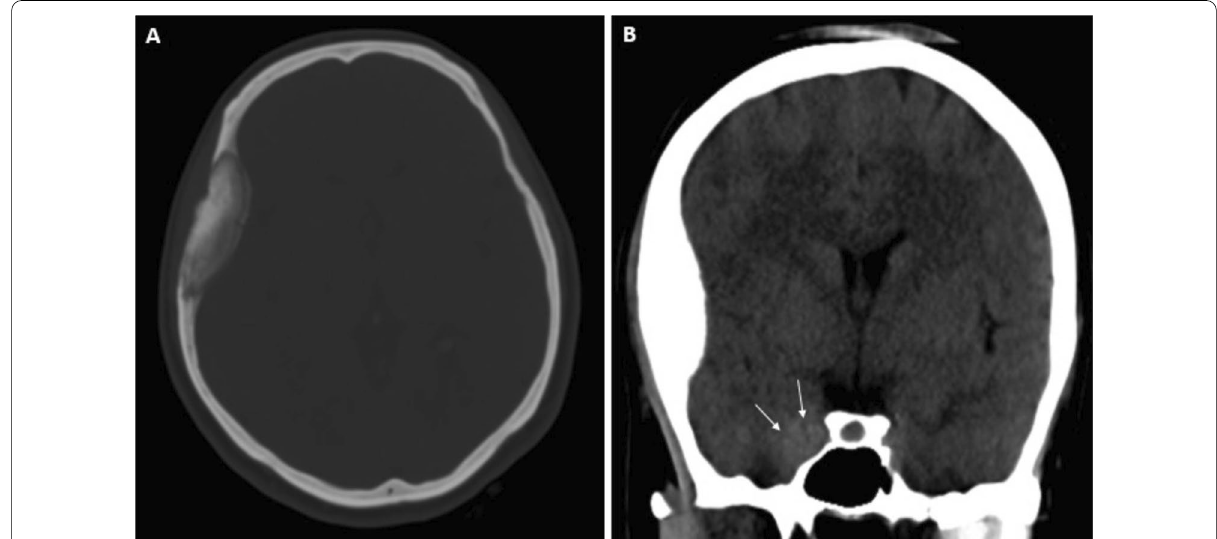
Fig. 1 In the axial section ( A ) of brain CT without contrast, in the right frontotemporal region an appearance of expansile, monostotic fibrous dysplasia is observed in ground glass density. In the soft tissue window of the coronal section ( B ), fullness in the right cavernous sinus draws attention (white